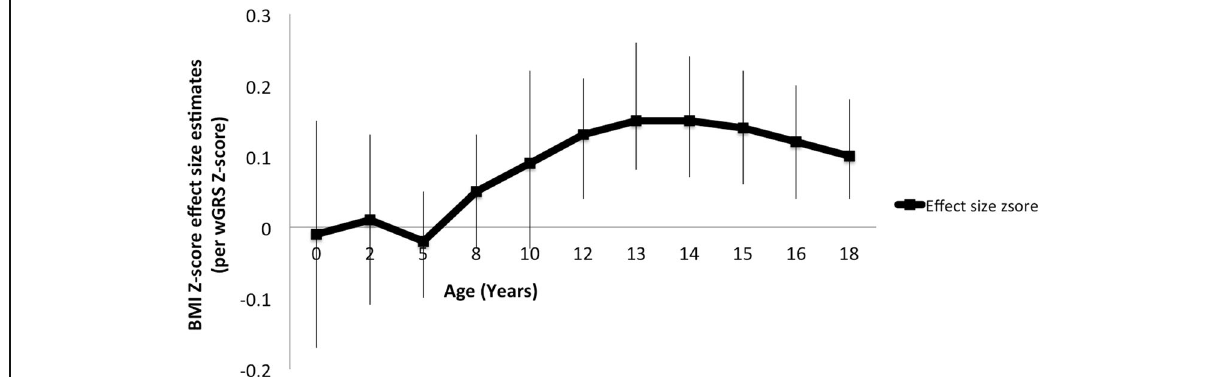
Fig. 1 Effect size estimates for BMI Z -score per Z -score increase in wGRS at each age adjusted for sex (error bars indicate 95% confidence intervals)